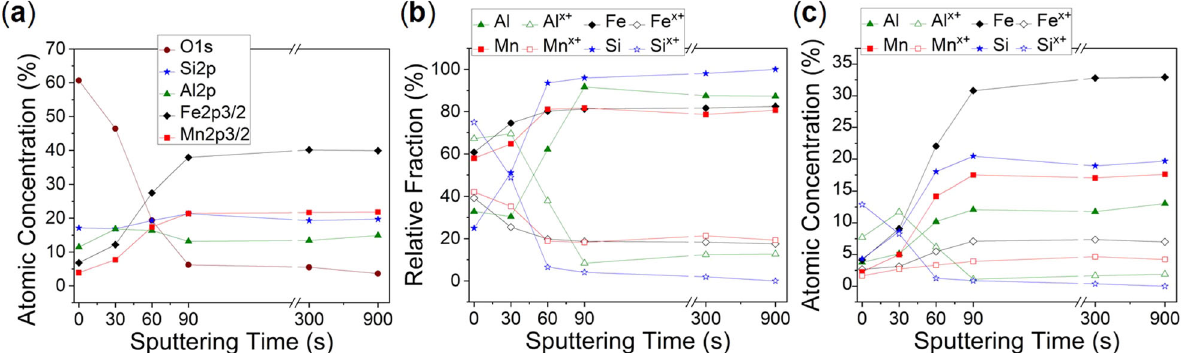
Fig. 4 XPS of the AlFeMnSi surface after 24 h immersion in 0.6 M NaCl. Distribution of elements as a function of sputtering time determined by XPS following 24 h immersion of the AlFeMnSi alloy in 0.6 M NaCl: a atomic concentration, b relative fraction of oxidized element to corresponding unoxidized metal species, and c atomic concentration of oxidized and unoxidized species.